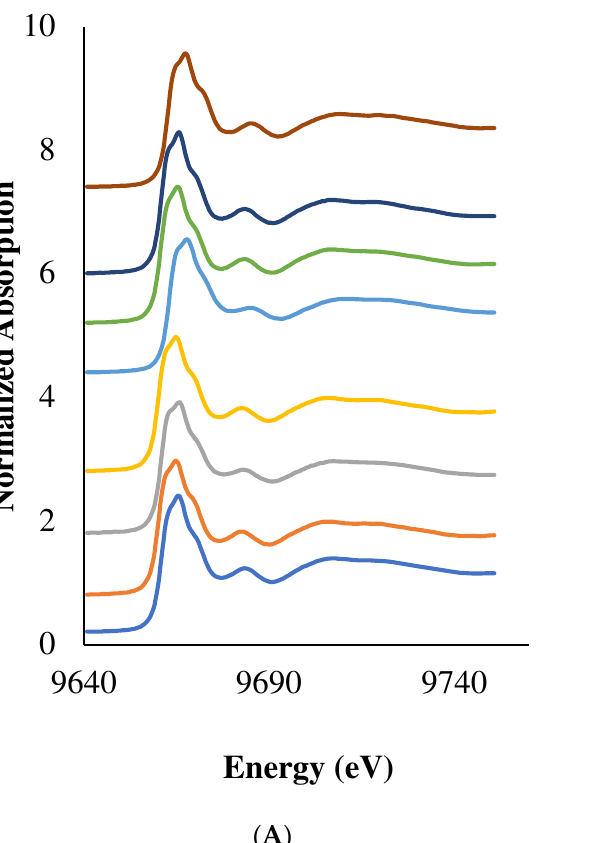
15 of 20 Figure 3. ( A ) Normalized Cu XANES K-edge spectra of post-harvest soils collected from landscape- based Cu fertilization field trials in south-central Saskatchewan conducted on Haverhill (upslope) and Echo (downslope) soil associations in a farm field. ( B ) Results of linear combination fit, showing the relative changes in Cu speciation among treatments. Treatments are C: unfertilized control; B: